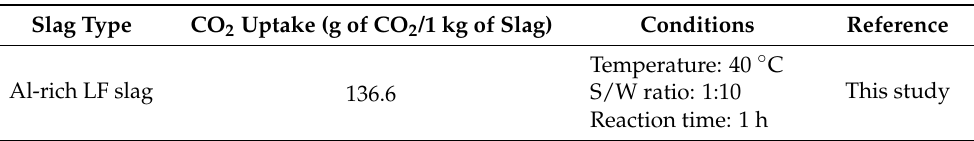
Table 6. Comparison of current with previous steelmaking slag carbonation studies conducted under ambient temperature and pressure .